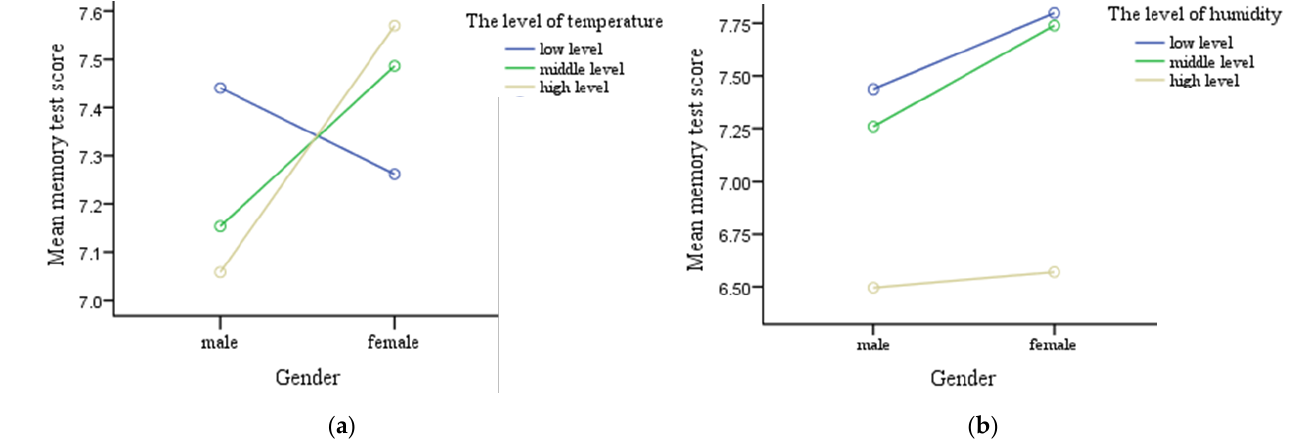
Figure 2. ( a ) Memory scores of different genders under different temperature levels. ( b ) Memory scores of different genders under different humidity levels.